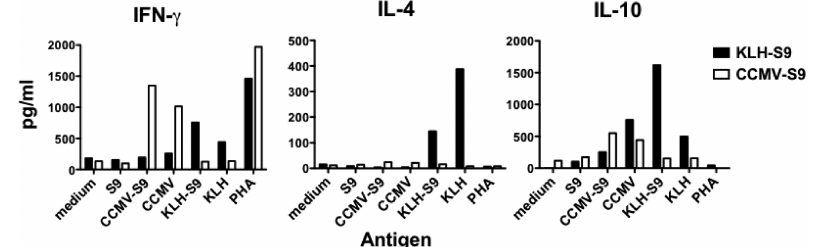
Figure 5. Cytokine production by lymphocytes from VLP- or carrier-immunized mice. Mice immunized with CCMV-S9 or KLH-S9 were boosted and, four days later, sacrificed. Lymphocytes from mesenteric lymph nodes and spleens were pooled from mice in each group and splenocytes isolated. The cells were incubated with the indicated antigens and cytokines in the cell supernatants measured on day 3 (IFN- γ ) or day 5 (IL-4 and IL-10) using cytokine capture ELISAs.